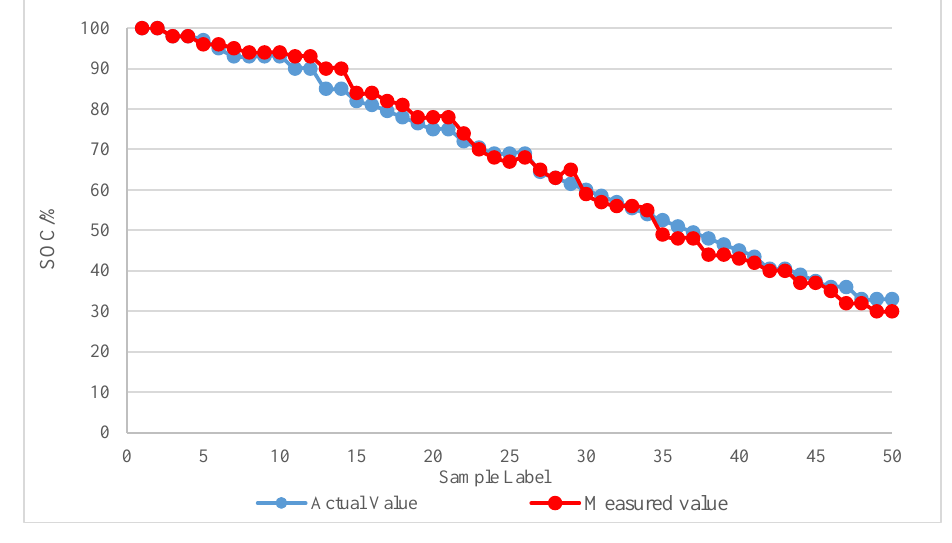
Figure 16. Comparison of SOC test results. Table 2. Comparison of proposed system with existing